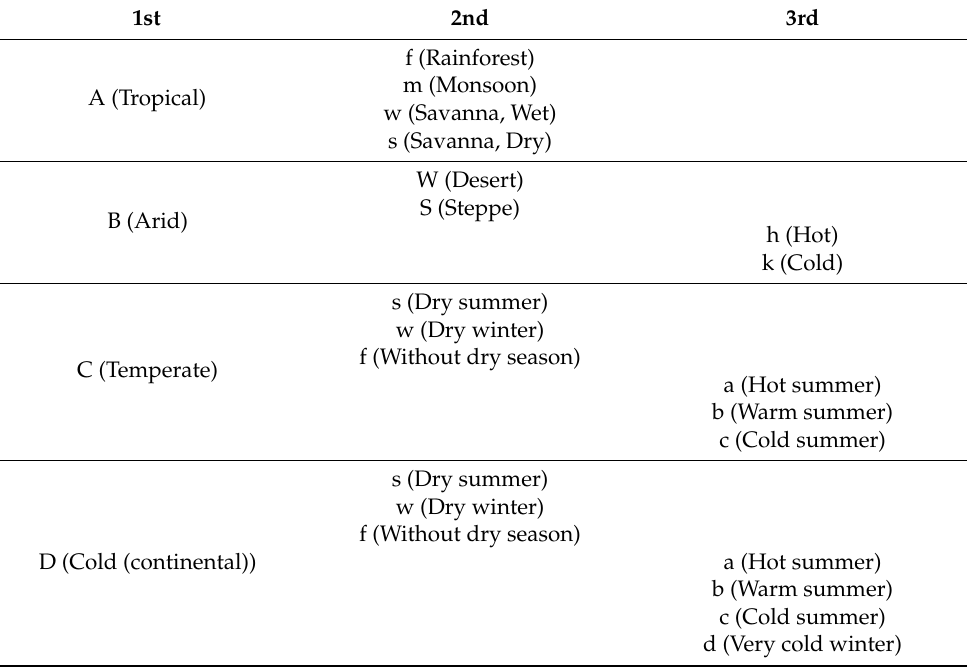
Table 8. Köppen climate classification scheme symbols description